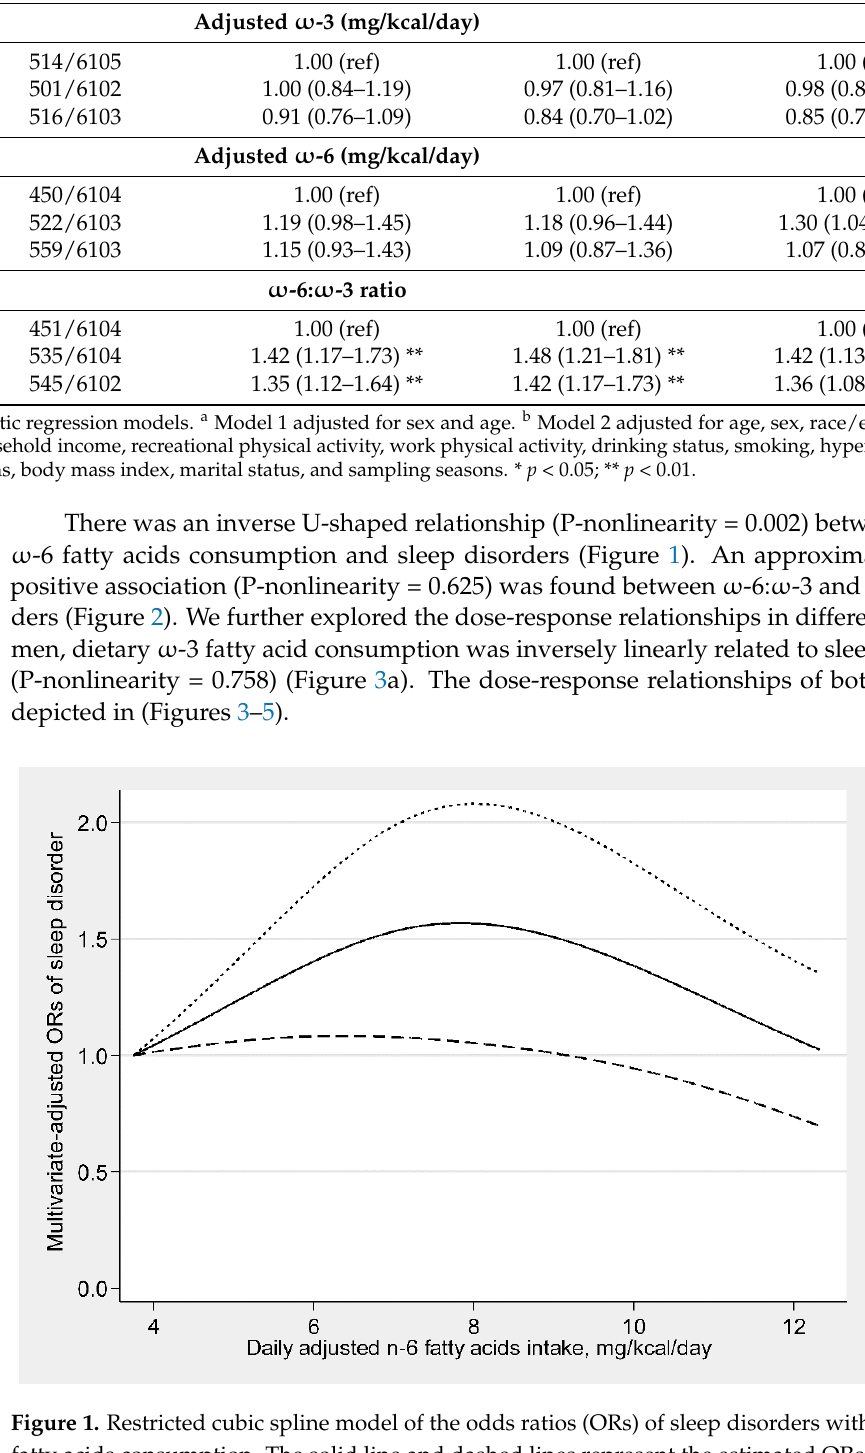
Figure 2. Restricted cubic spline model of the odds ratios (ORs) of sleep disorders with dietary ω- 6:ω-3 ratio. The solid line and dashed lines represent the estimated ORs and the 95% confidence intervals, respectively.